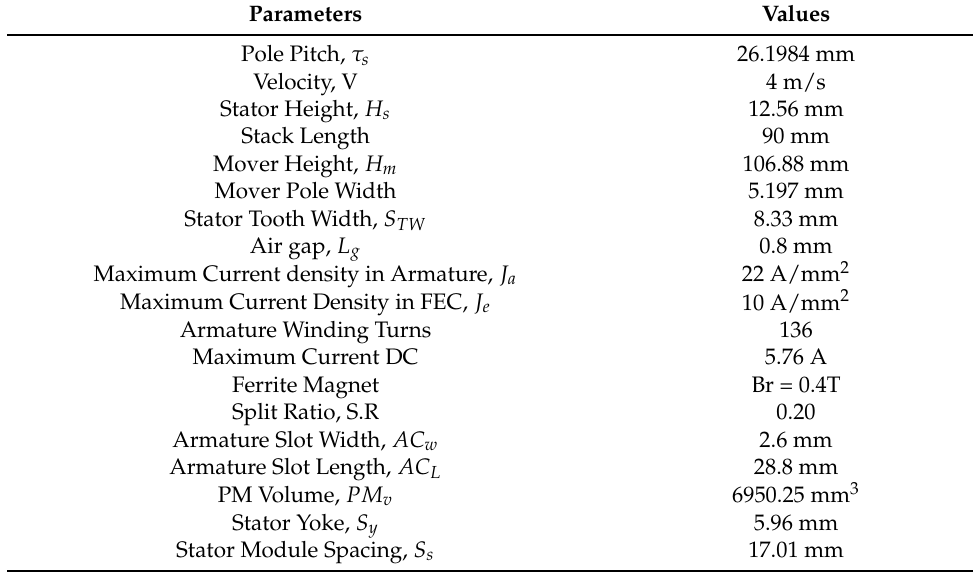
Table 1. Detailed design parameter of the proposed model.